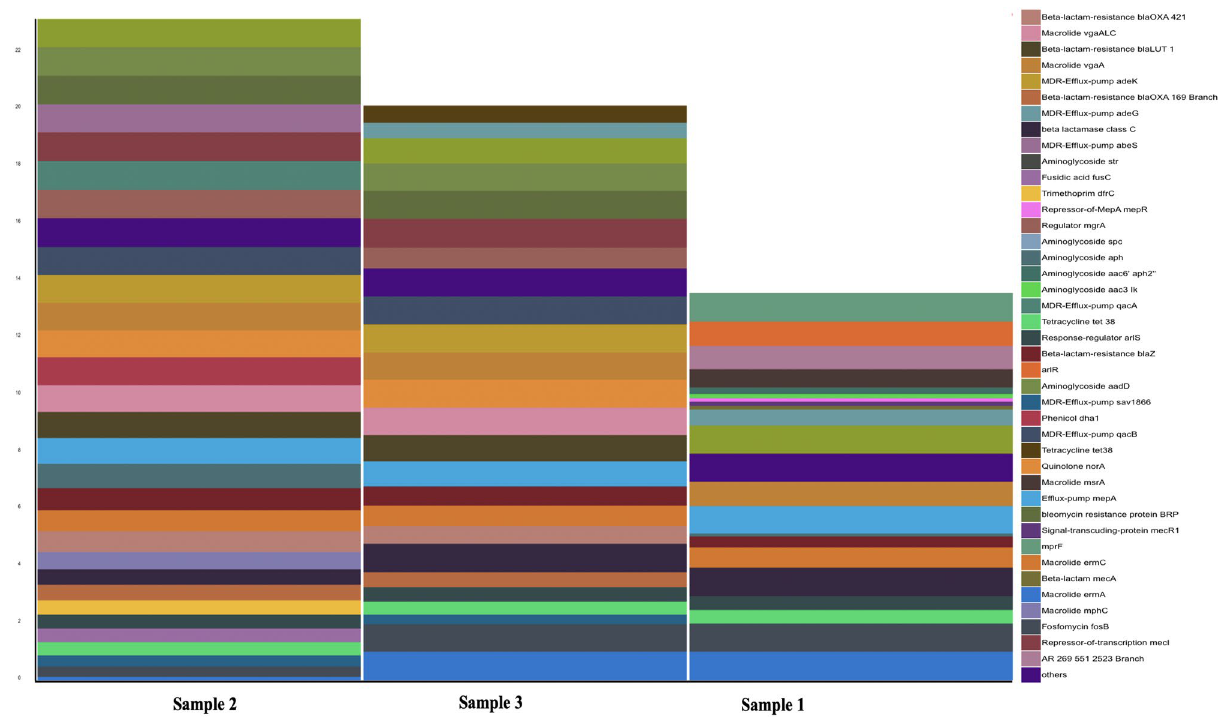
Figure 7. Individual metagenome distribution of identified antibiotic resistance genes from community derived phone